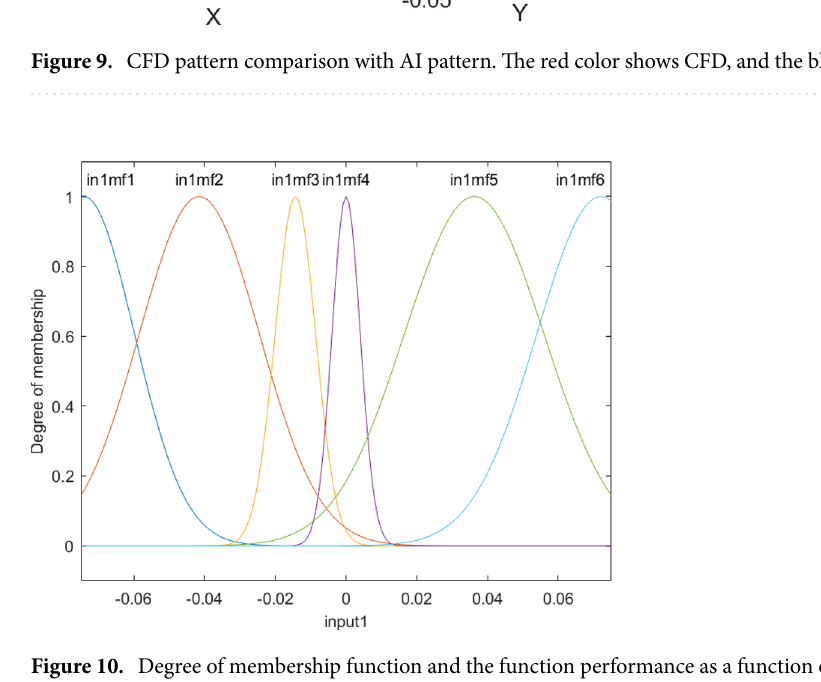
Figure 10. Degree of membership function and the function performance as a function of the first input for six membership functions for each input parameter.